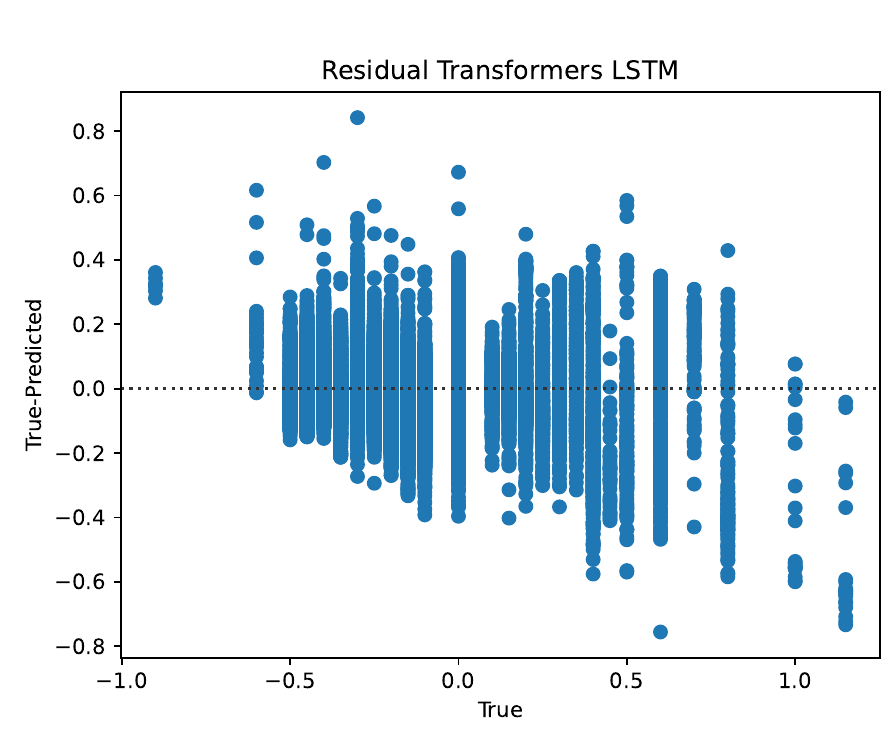
Figure 13. Transformers LSTM results for ST deviation calculation in ECG time